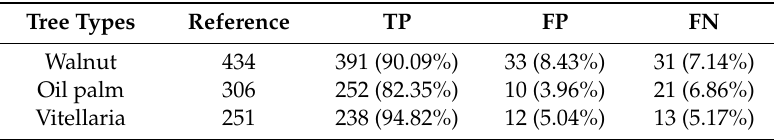
Table 1. Detected tree objects based in discrete scale space, using model f 3 ( s ).